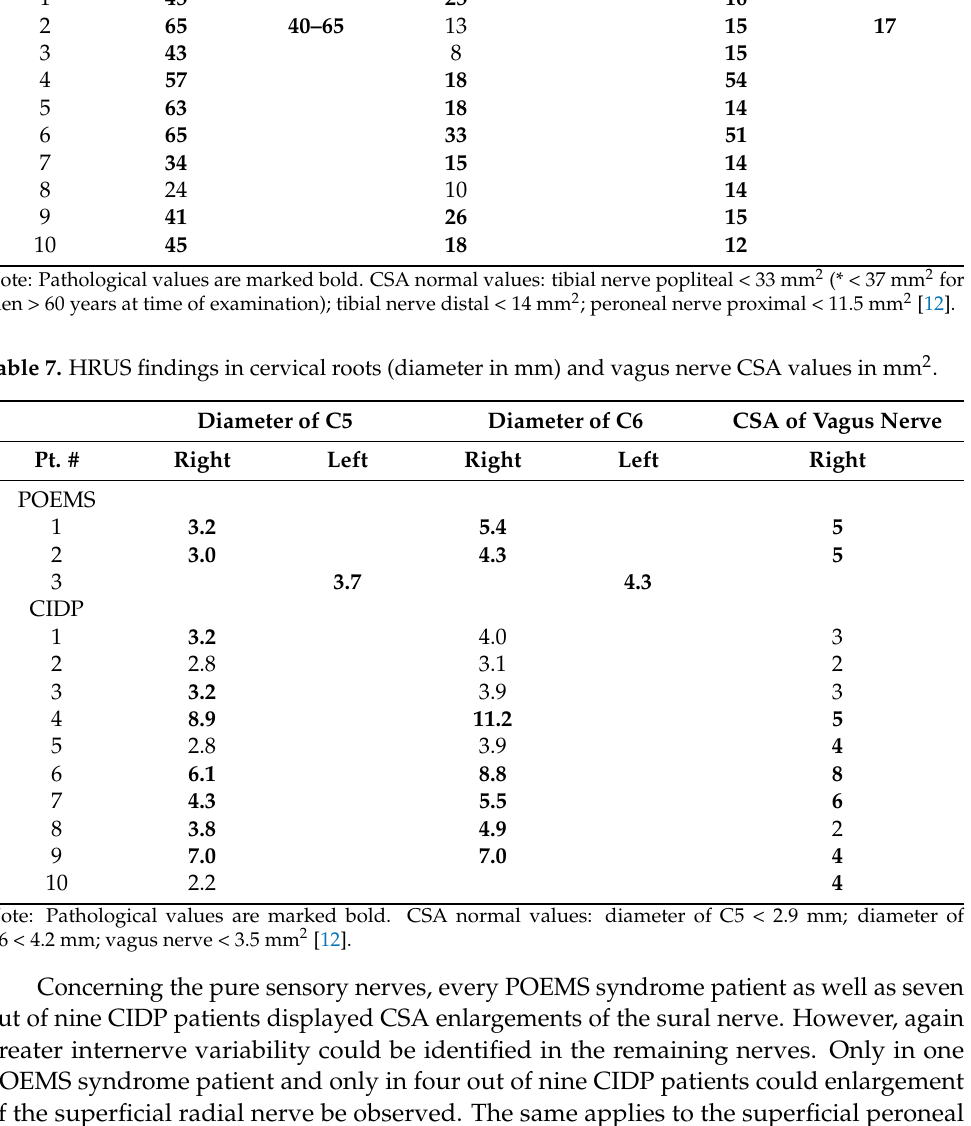
Table 6. HRUS findings in lower limb nerves: tibial and peroneal nerve CSA values in mm 2 . Tibial Nerve Popliteal Tibial Nerve Distal Peroneal Nerve Proximal Pt. # Right Left Right Left Right Left POEMS 1 22 11 11 57 *